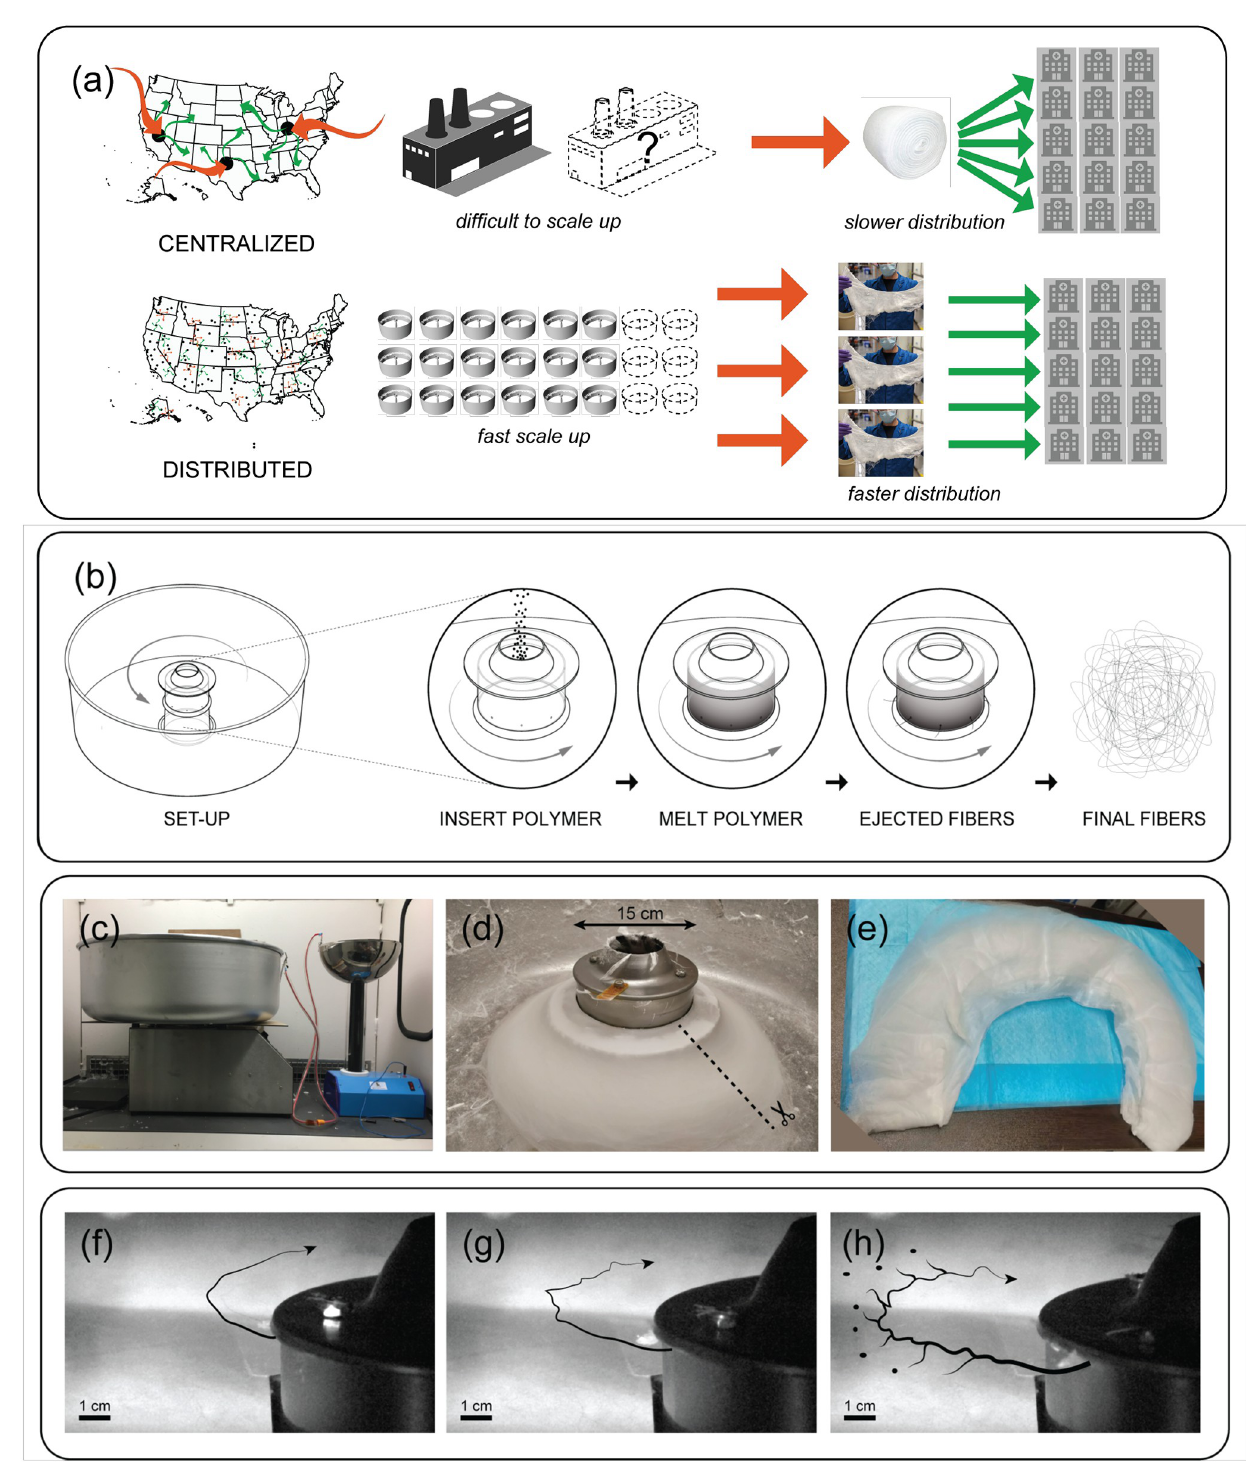
Fig 1. Distributed manufacturing and cotton candy machine for production of non-woven filtration media. A: Distributed manufacturing paradigm allows for flexible, local production of material anywhere in the the world on short notice. B: Schematic illustration showing key steps of RJS process to produce non-woven fiber mats. C: Implementation of RJS using a retrofitted, commercially-available cotton candy machine. D-E: the process deposits fibers in a mat that can be collected and processed into filtration media. F: High speed camera footage showing ejection of material from the spinneret and onset of a Rayleigh-Taylor instability G-H: leading to the formation of nano- and microscale fibers from extrusion holes much larger in size( * 500 − 1000 μm ).